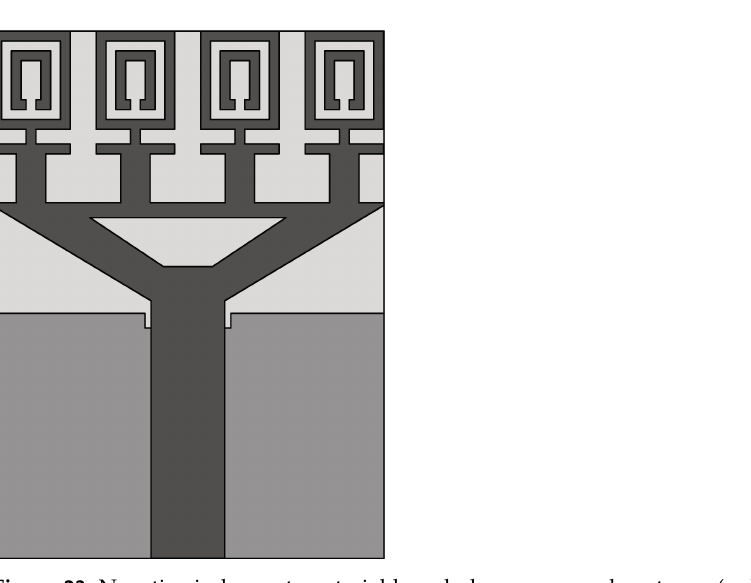
Figure 23. Negative index metamaterial-based planar monopole antenna (redrawn from [87]). Dark gray top metal face, medium gray bottom metal face, and light gray dielectric